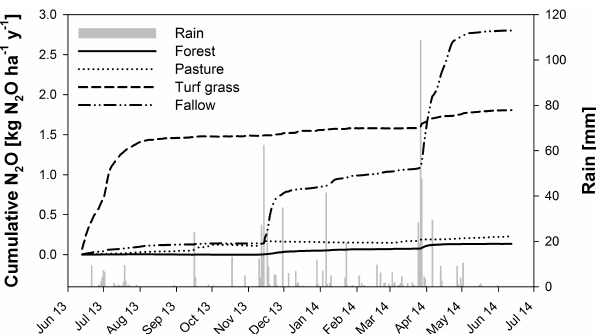
Figure 3. Cumulative daily N 2 O fluxes ( n = 3) for forest, pas- ture, turf grass, and fallow with rainfall for the experimental year 2013 /